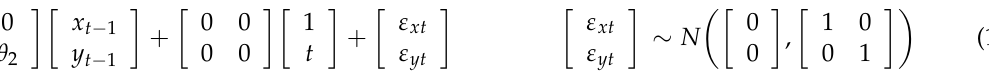
Scenario 2: Generate two independent nonstationary series without drift and trend by imposing restriction on a 1 = b 1 = 0, θ 12 = θ 21 = 0 and ρ = 0.